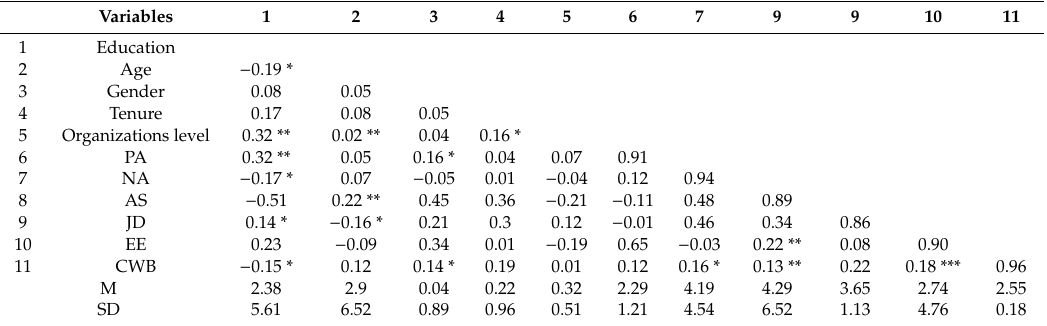
Table 2. Mean, Correlation, Standard Deviation for all original variables.